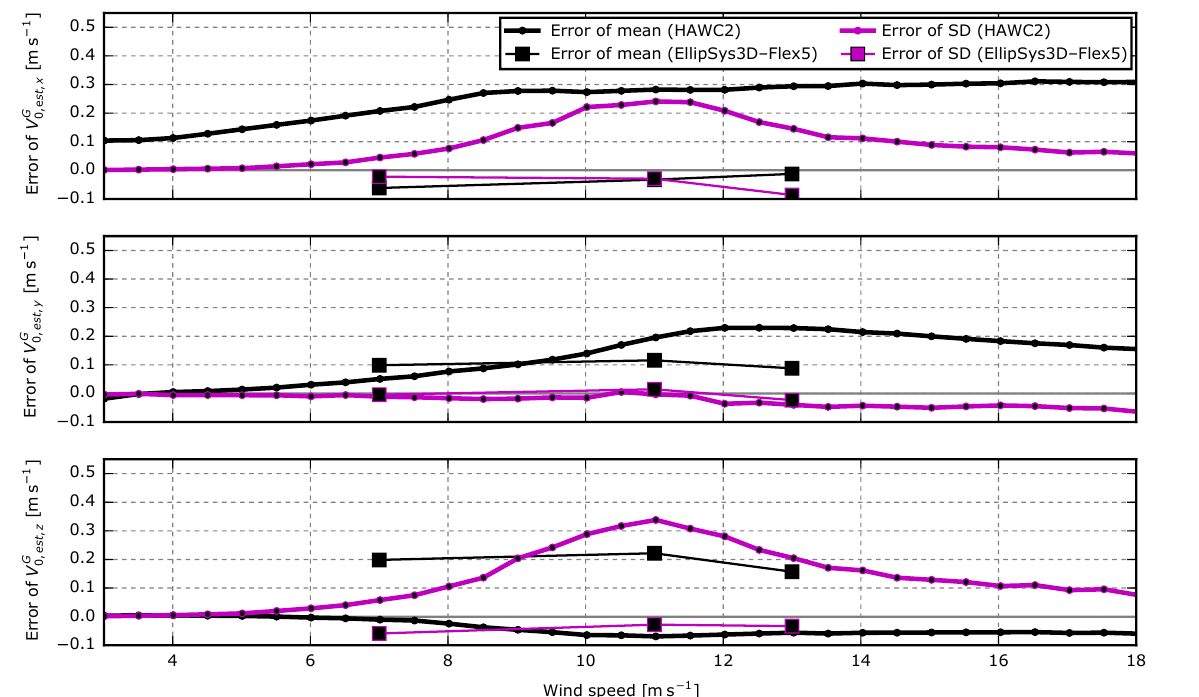
Figure 19. The difference between the mean/SD of the free wind speed at the position of the sensor and the mean/SD of the estimated free wind speed. The HAWC2 results are based on 10min of simulations of the Siemens 3.6MW turbine. The deviations are mainly introduced in the mapping of velocities from the deflected blade-section coordinate system to the ground coordinate system. The EllipSys3D–Flex5 results are based on 200s of simulations of the Siemens 2.3MW turbine. In this case, the deviations are mainly introduced by differences in the induction modelling approach. Both results are obtained from simulations of a flexible structure in turbulent inflow without